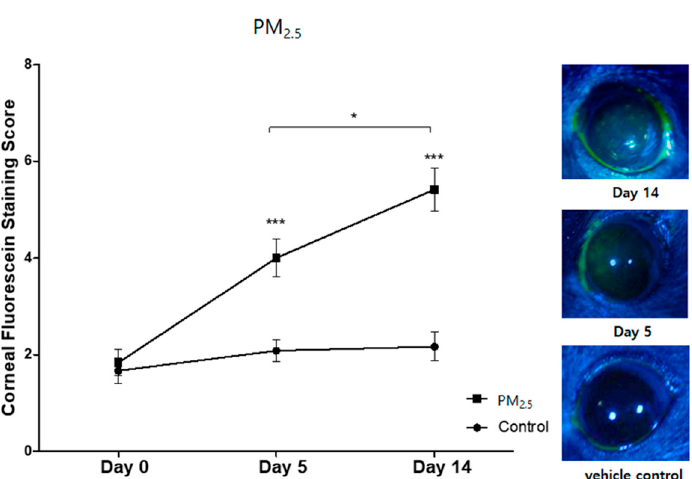
Figure 1. Traffic-related PM 2.5 challenges led to a significant increase in the corneal fluorescein staining score compared to the vehicle control at Day 5 and Day 14. * p < 0.05, *** indicates p < 0.0001. Data are presented as the mean ± standard error of the mean (SEM) of three experiments. Each experiment consisted of eight mice per group.